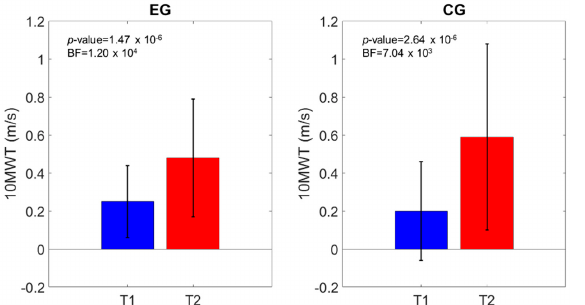
Figure 5. 10MWT velocity comparison of the scores at T1 and T2. The p -value and the BF of the intragroup effects are shown.